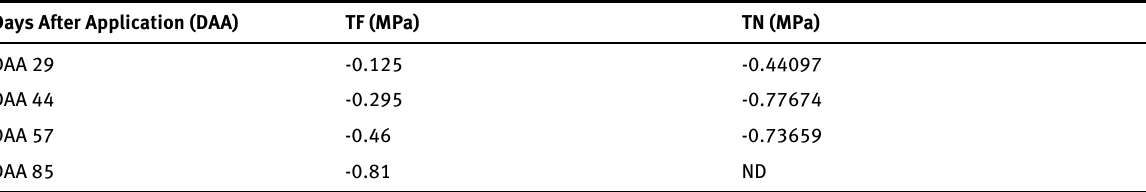
Table 1: Predawn leaf water potential for Touriga Franca (TF) and Touriga Nacional (TN) in each data of measurement Days After Application